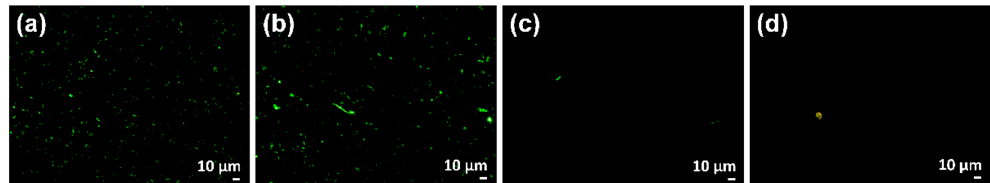
Figure 8. Fluorescence images of untreated E. coli ( a ) and the cells treated with M41–Z ( b ) as the negative control, free Cin ( c ) and M41–Cin–Z ( d ) after 5 h of incubation. The study was performed using a two-color fluorescent LIVE/DEAD ® Bac Light™ assay used to visualize viable (green) and dead (red) bacteria. Red-stained bacteria are not visible when dead cells do not remain intact after treatment.